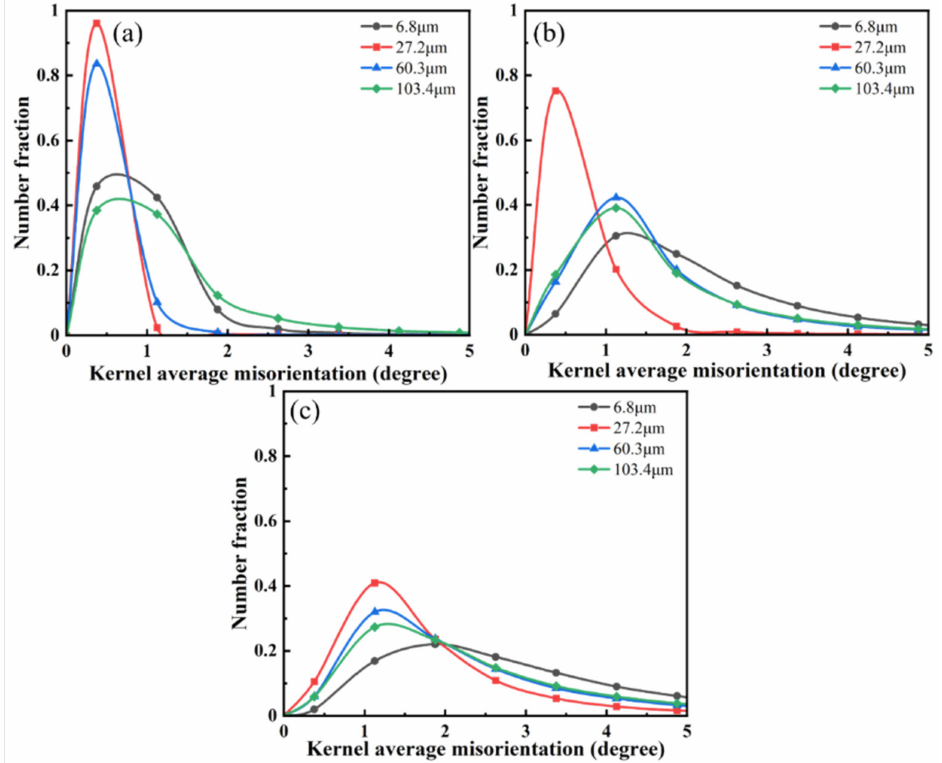
Figure 12. KAM distributions of annealed samples with different grain sizes under different reduction: ( a ) 10%; ( b ) 20%; ( c )